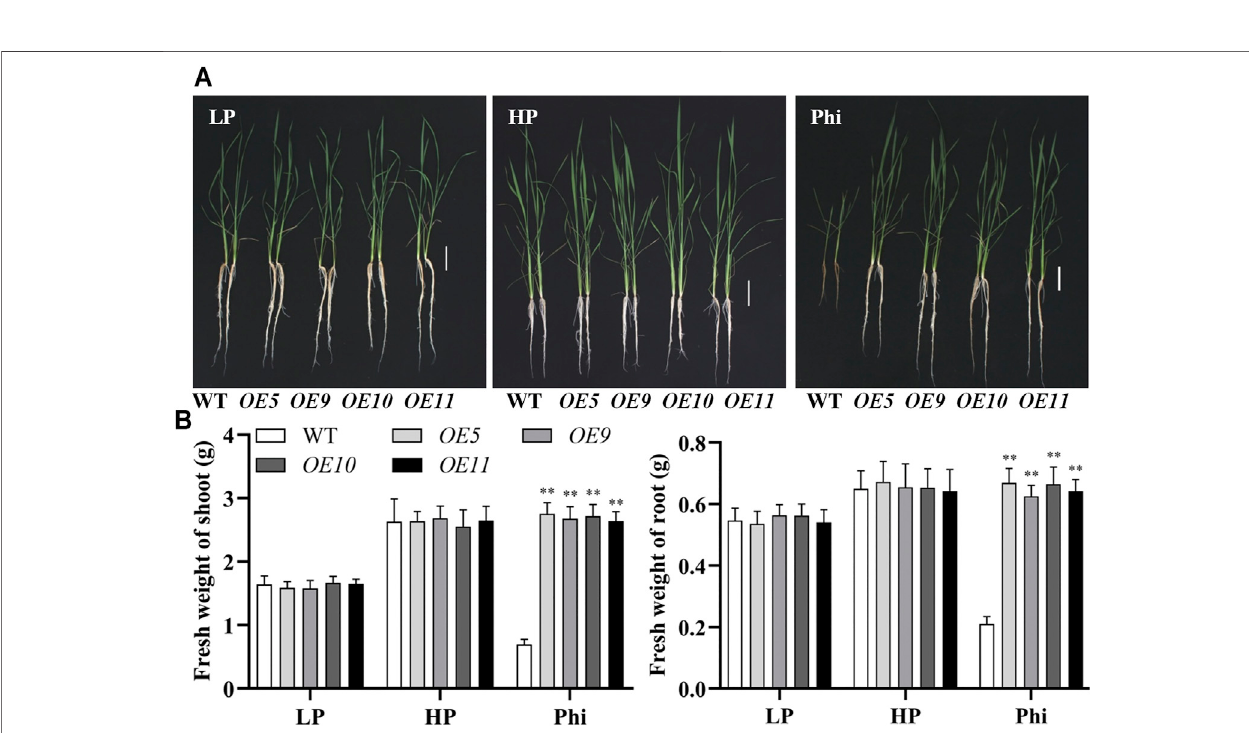
FIGURE 4 | Growth performance (A) and fresh weight (B) of WT ( ZH11 ) and ptxD Q overexpression ( OE5 , OE9 , OE10 , and OE11 ) rice with different P sources. Fourteen-day-old seedlings were transferred to nutrient solutions containing 10 μ M phosphate (LP), 300 μ M phosphate (HP), or 300 mM phosphite (Phi). Scale bar (cid:2) 5 cm. The data are shown as means ± SD for fi ve replicates. Asterisks indicate signi fi cant differences as compared with WT plants (Turkey ’ s test, ** p ≤ 0.01).